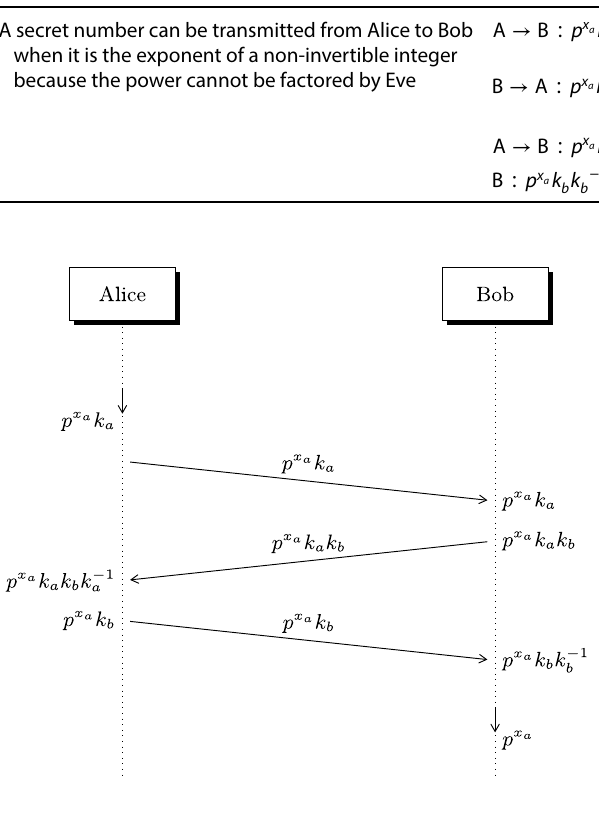
Fig. 2 The exponent-based protocol. All computations in the pro- tocol are performed mod pq . The non-invertible number p x a is mul- tiplied by the invertible k a before it is sent to Bob